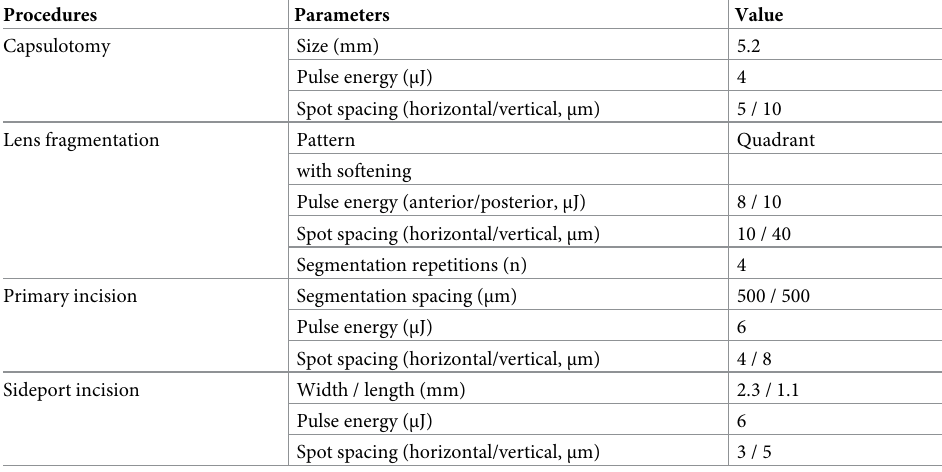
Table 1. Parameters for femtosecond laser-assisted